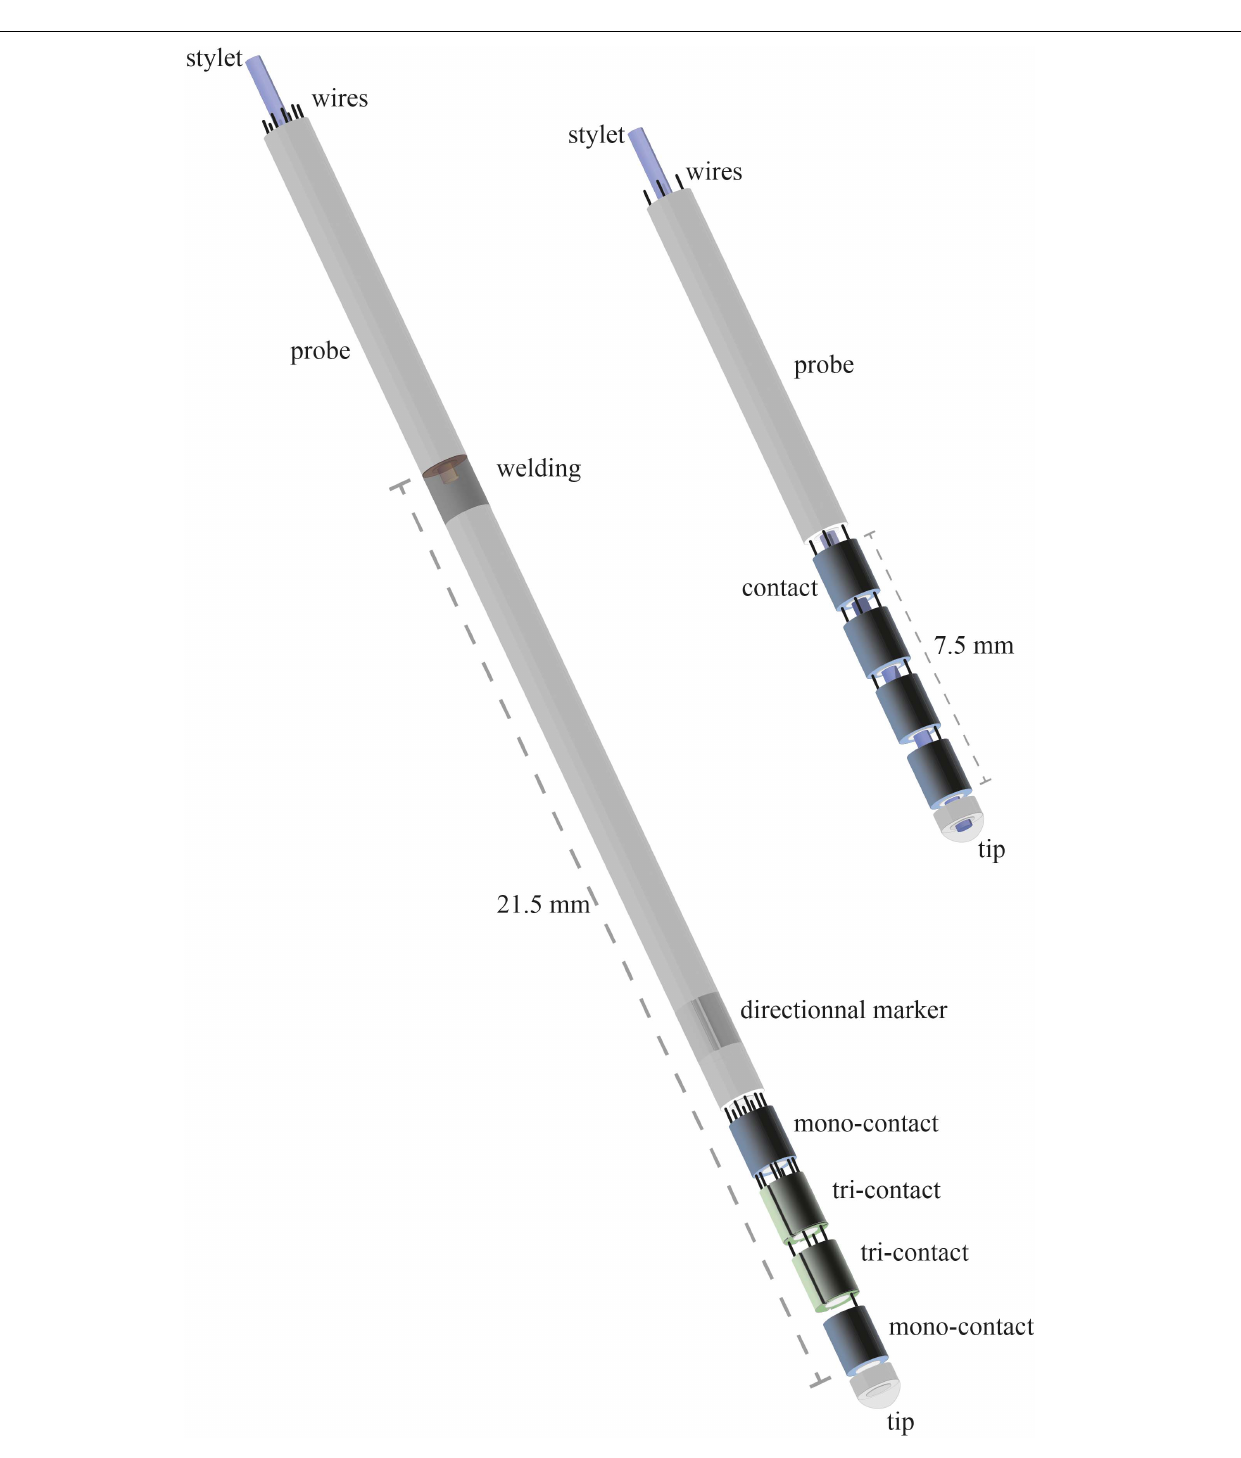
shift, and surgical inaccuracy were studied in a series of 30 consecutive patients operated on bilaterally and using two kinds of electrodes: a historical, non-directional, electrode, where